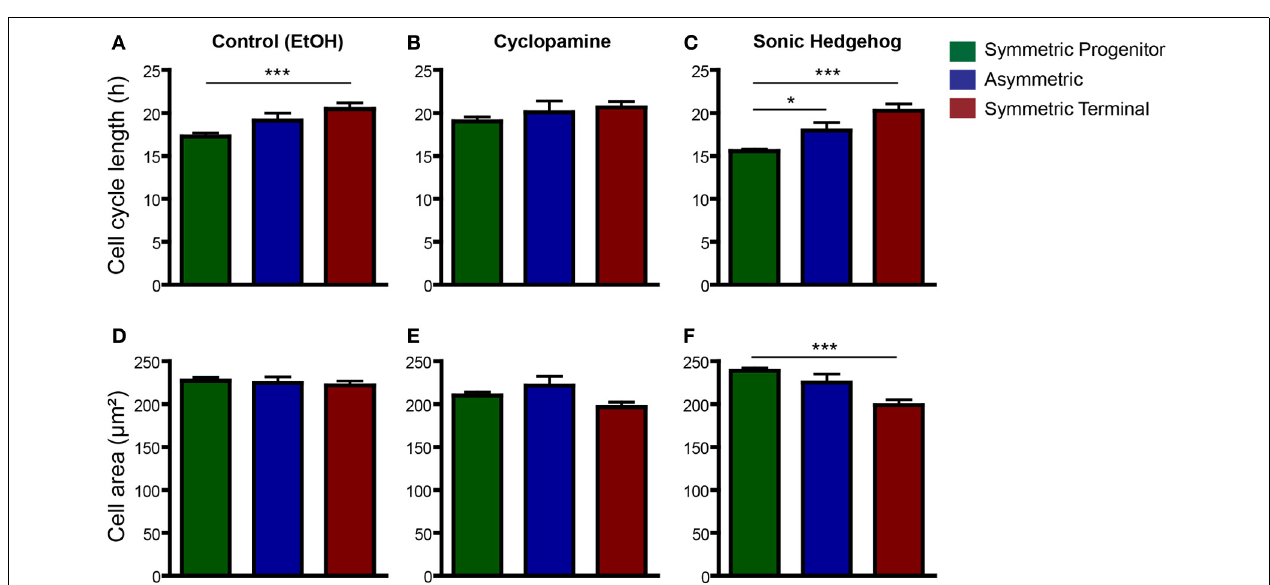
progenitors undergoing SP (D) , As (E), or ST (F) cell division. ∗ p < 0 . 05, ∗∗ p < 0 . 01, ∗∗∗ p < 0 . 001, One-Way ANOVA followed by Dunnet post-hoc test (Number of cells analyzed, SP control: 123, SP cyc: 100, SP SHH: 224; As control: 38, As cyc: 18, As SHH: 21; ST Control: 95, ST cyc: 60, ST SHH: 45).